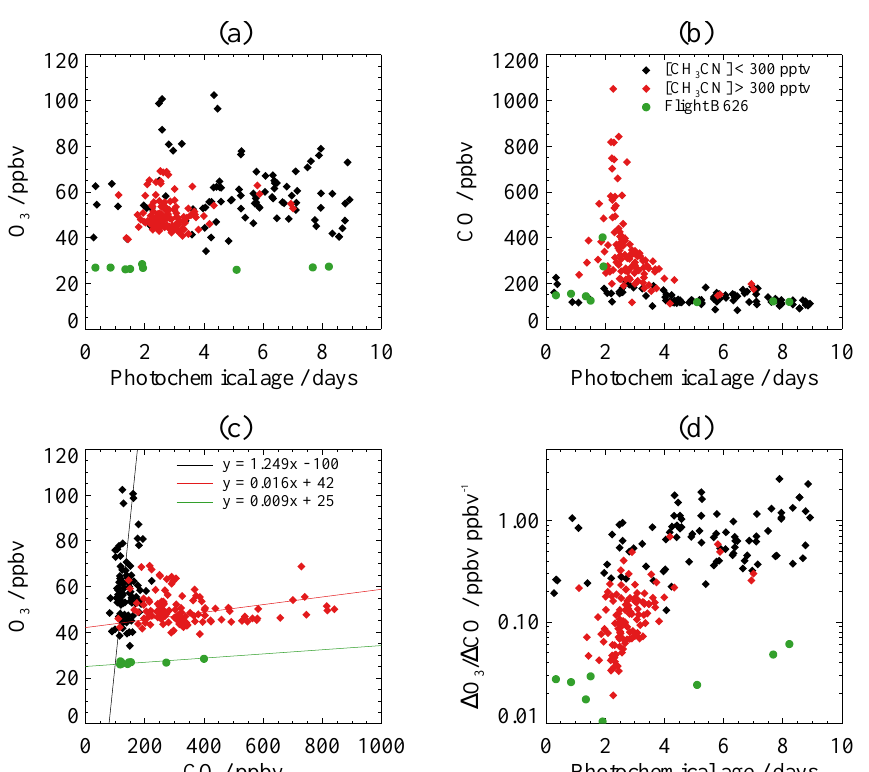
Fig. 6. Relationship between O 3 and CO mixing ratios measured from the BAe-146 and sampled at the WAS measurement times, and photochemical ages calculated from the ln(C 3 H 8 /C 2 H 6 ) ratio in boreal biomass burning plumes throughout the BORTAS-B measurement campaign and assuming an OH concentration of 2 × 10 6 moleculescm − 3 . (a) and (b) show the measured O 3 and CO mixing ratios, respec- tively, in units ofppbv as a function of the calculated photochemical age in days. (c) shows the scatter of O 3 versus CO with straight lines showing linear fits to each population of data points. (d) shows the enhancement of O 3 relative to CO ( 1 O 3 / 1 CO) as a function of photo- chemical age. In all plots the data are filtered according to their relative abundance of CH 3 CN, with black diamonds representing CH 3 CN mixing ratios between 150 and 300pptv and red diamonds representing CH 3 CN mixing ratios in excess of 300pptv. Measurements made on flight B626 over the fire region in Northwestern Ontario are treated separately and are represented by green